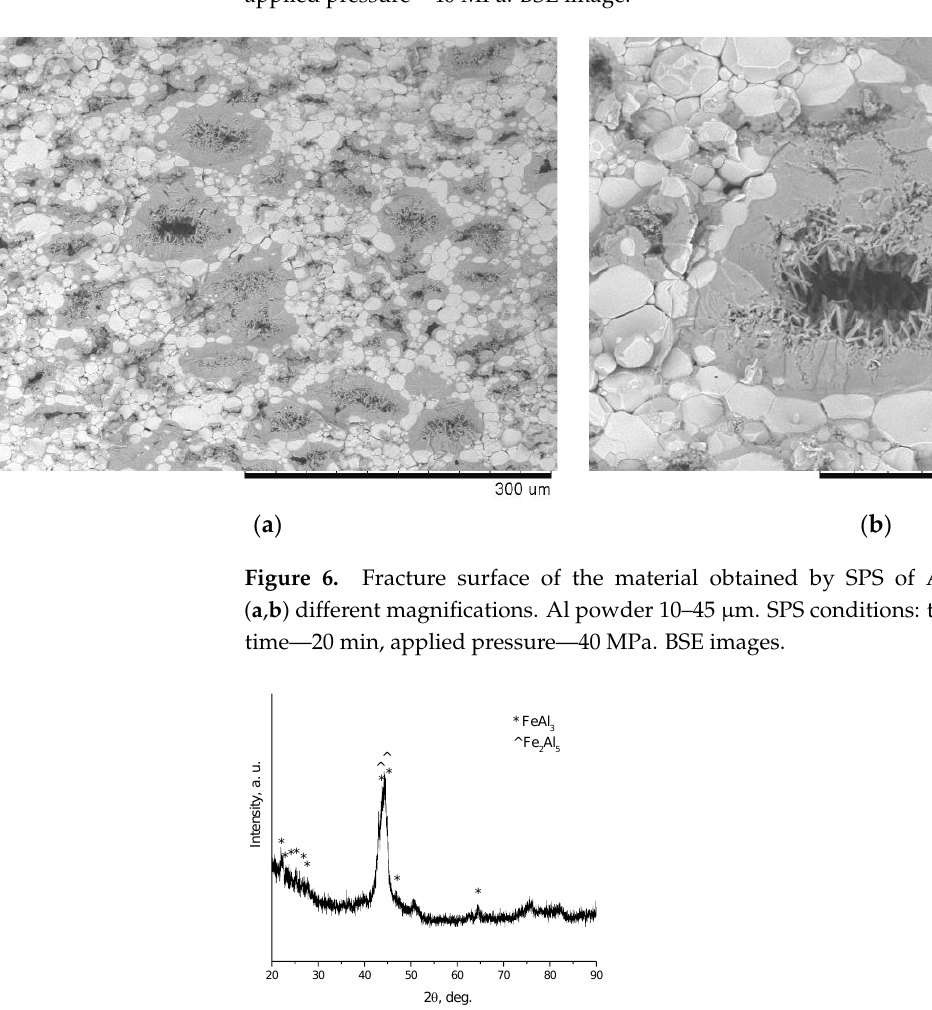
Figure 7. XRD pattern of the material obtained by SPS of Al–70 vol.% Fe 66 Cr 10 Nb 5 B 19 . SPS conditions: temperature — 570 °C, holding time — 20 min, applied pressure — 40 MPa.